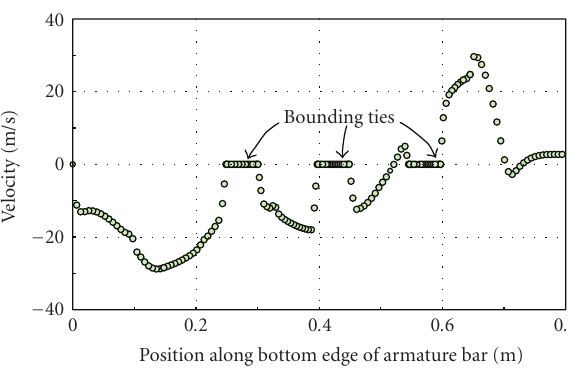
(a) Axial velocity profile along the bottom edge of the armature bars